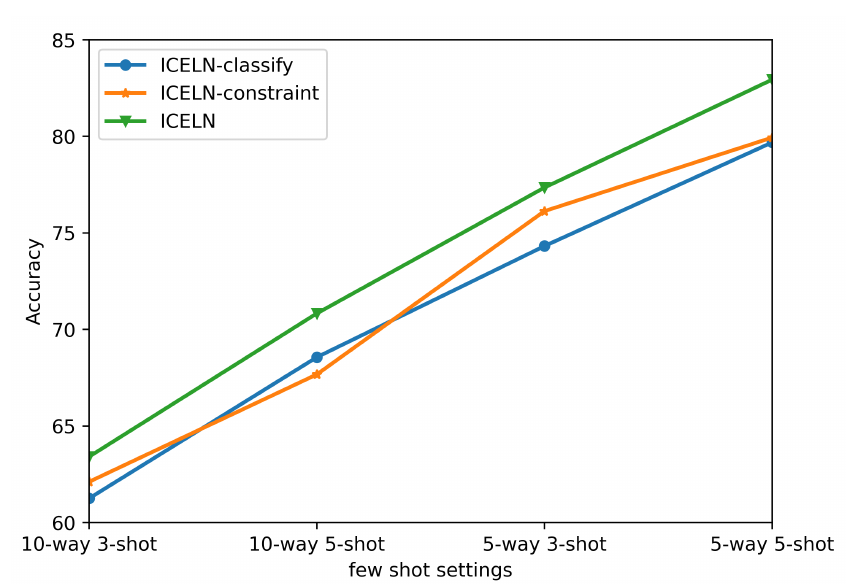
Figure 5. Ablation study on DBLP.